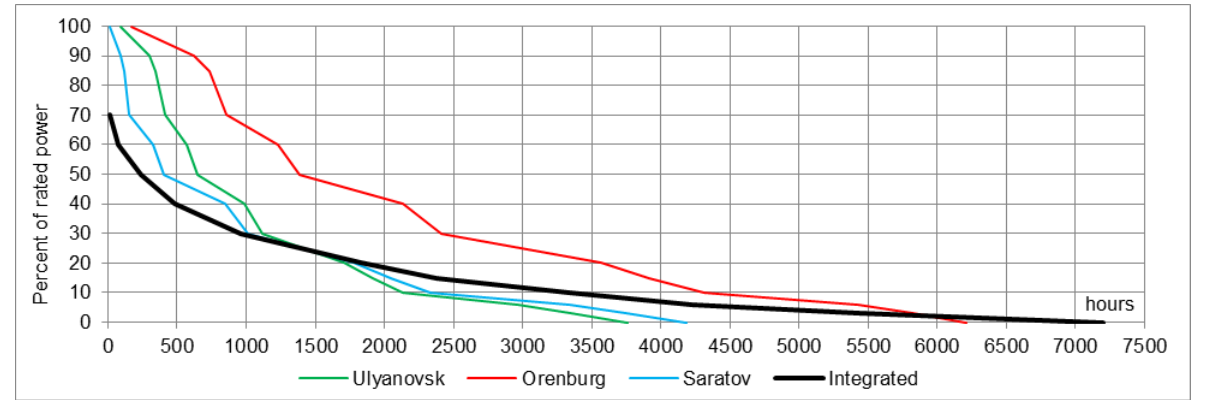
Fig. 3. Comparison of wind power duration curves